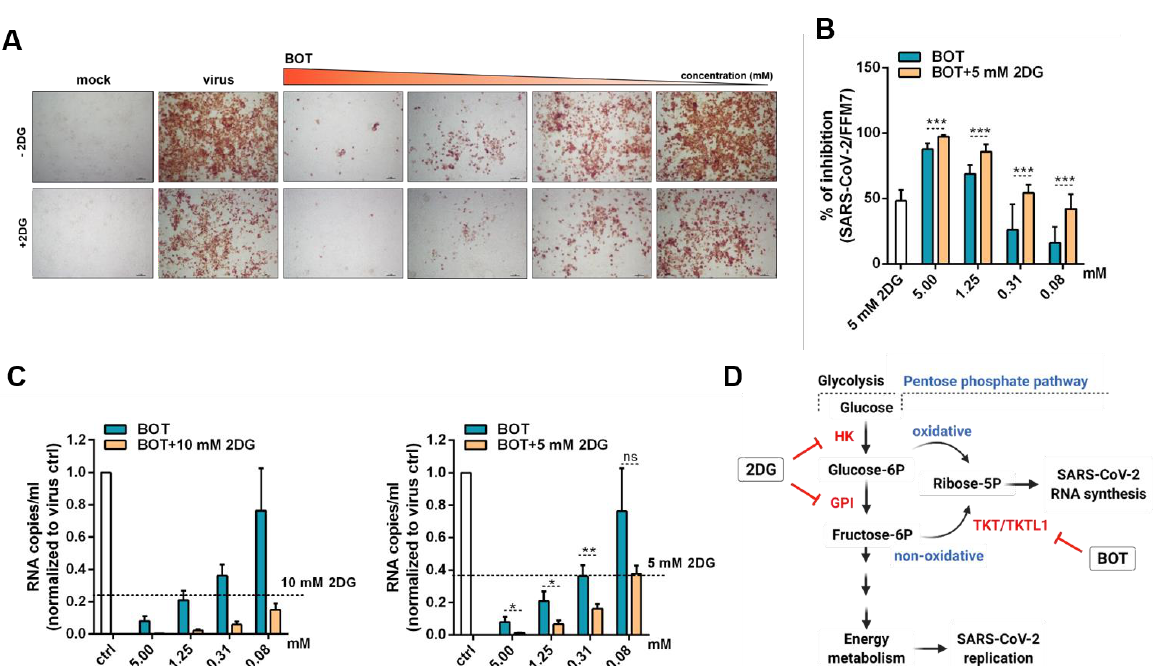
Figure 4. Inhibition of viral infection in benfooxythiamine (BOT)-treated cells in combination with 2-deoxy- D -glucose (2DG). Caco-2 cells were pre-treated with different concentration of BOT for 24 h. Then, the 2DG at concentration 5mM or 10 mM was added and cells were infected with SARS-CoV-2/FFM7 at MOI 0.01. ( A ) Representative images illustrating immunohistochemistry staining of SARS-CoV-2 spike protein in SARS-CoV-2/FFM7 infected Caco-2 cells treated with BOT in combination with 2DG. ( B ) Quantification of illustrating immunohistochemistry staining of SARS-CoV-2 spike protein in SARS-CoV-2/FFM7 infected Caco-2 cells treated with BOT in combination with 2DG. Values represent the mean ± SD of the three independent experiments. p -values were determined with a two-sided unpaired t -test. *** p ≤ 0.001 ( C ) Quantification of viral genomes in supernatant of SARS-CoV-2 infected Caco-2 cells treated with BOT in combination with 2DG or BOT alone. SARS-CoV-2/FFM7 RNA copy numbers used the RNA-polymerase (RdRp) gene by qRT-PCR of RdRp gene. Values represent mean ± SD of the three independent experiments. p -values were determined with a two-sided unpaired t -test. ns: not significant; * p ≤ 0.05; ** p ≤ 0.01. Effects of BOT in combination with 2DG on cell viability are provided in Supplementary Figure S1. ( D ) Simplified scheme of glycolysis and pentose phosphate pathway. The targets for 2DG and BOT are depicted in red. The scheme was created with BioRender.com (accessed on 18 August